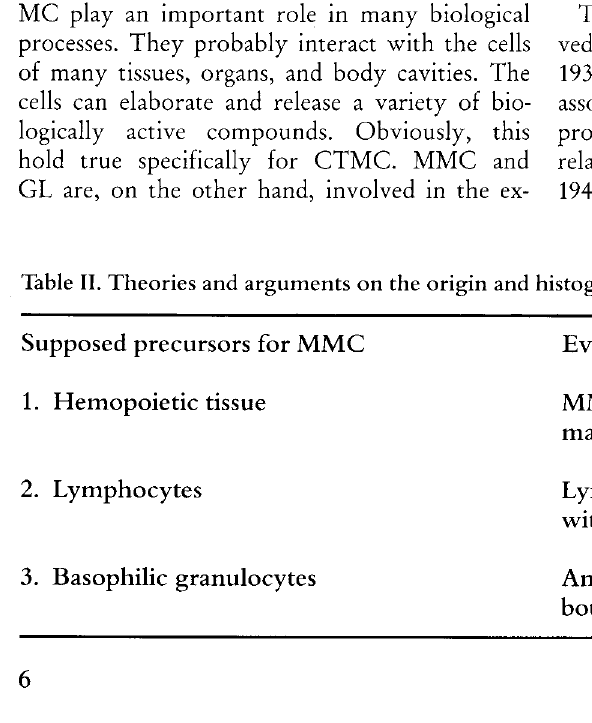
Table II. Theories and arguments on the origin and histogenesis of MMC Supposed precursors for M